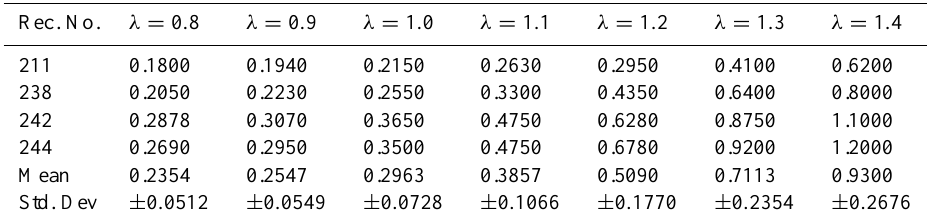
Table 3. Adapted γ values from Black Sea data.